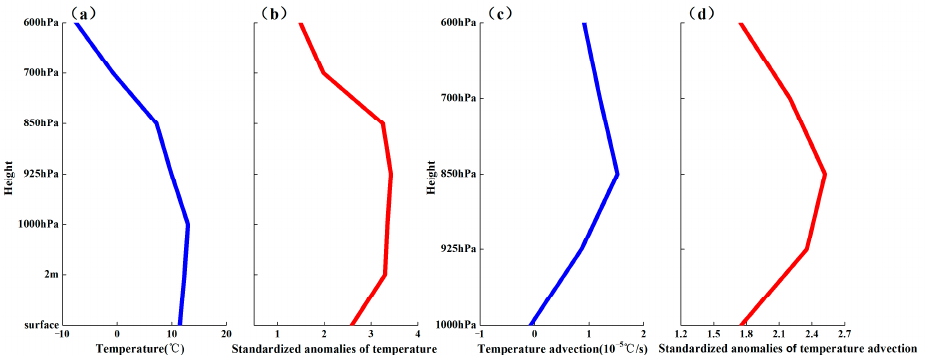
Figure 8. The profiles of the vertical distribution of composite ( a ) temperature, ( b ) standard anomalies of temperature, ( c ) temperature advection, and ( d ) standard anomalies of temperature advection averaged over the area of 115–122° E, 30–35° N in Eastern China from 24 November to 3 December in 2018.